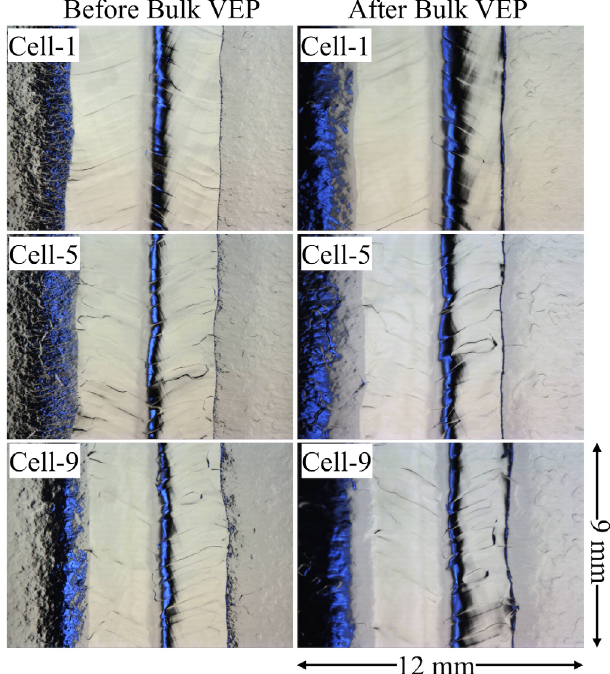
FIG. 23. Equator surfaces in the top, center, and bottom cells of the TB9-TSB01 cavity before (left images) and after (right images) bulk VEP for 100 μ m removal. The same positions of the equator are compared. Cell 1 represents the top cell. All the images have the